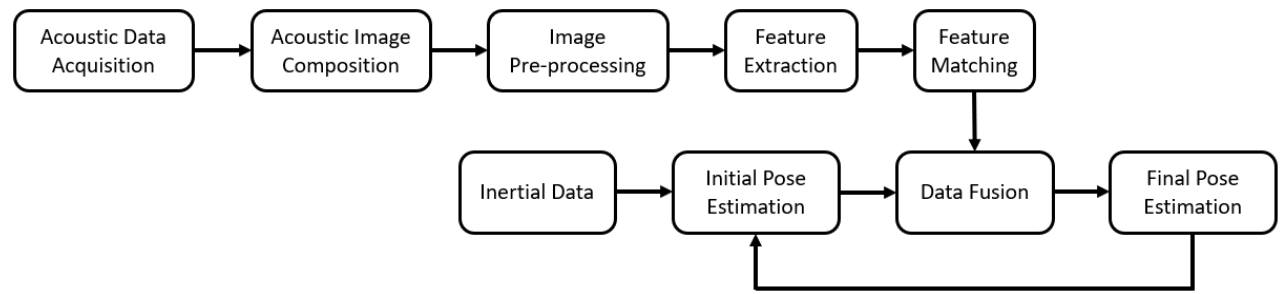
Figure 1. Principle diagram for acoustic image-based underwater navigation.